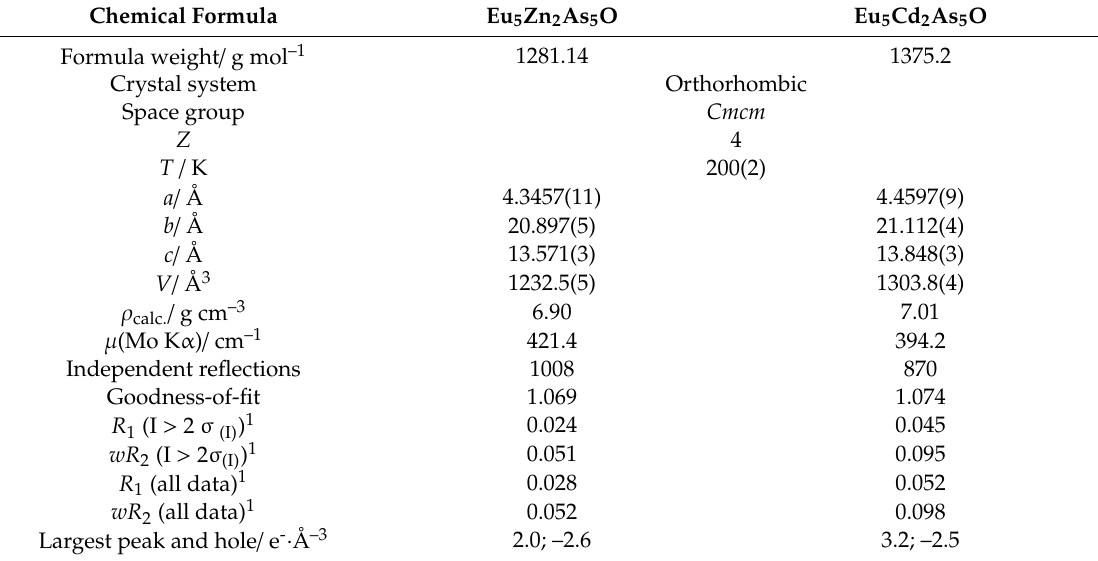
Table 1. Selected single-crystal data collection and structure refinement parameters for Eu 5 Zn 2 As 5 O and Eu 5 Cd 2 As 5 O.